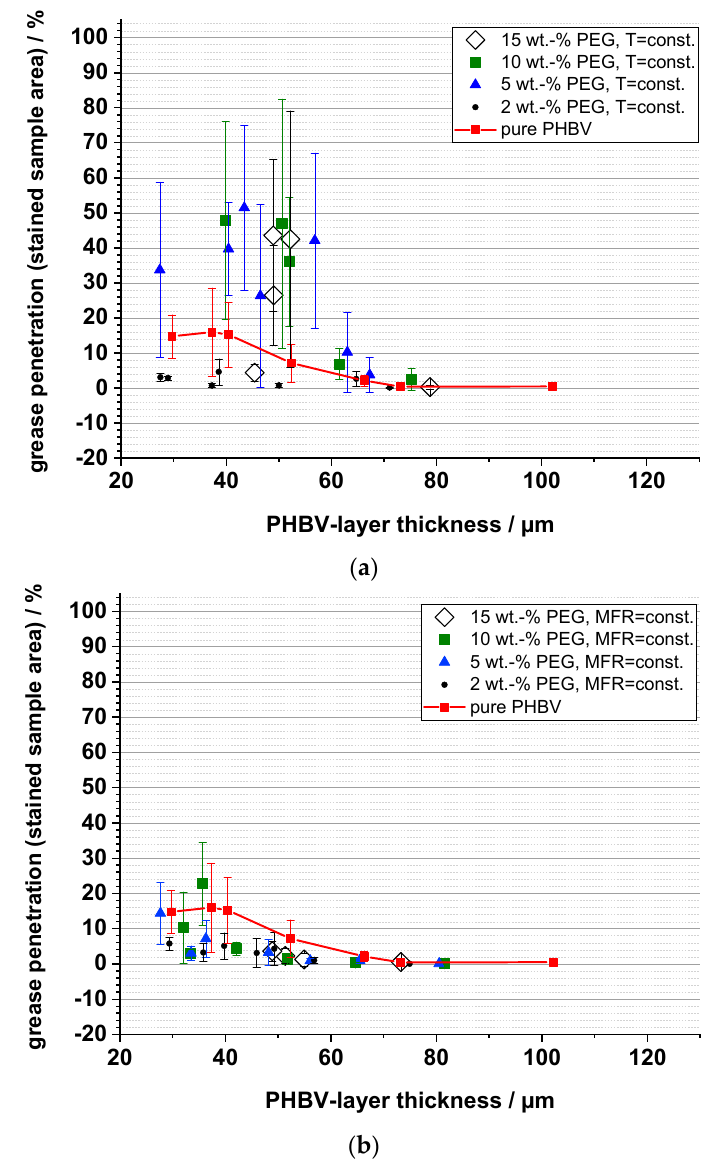
Figure 15. Grease barrier (staining) of paper coated with PHBV layers blended with polyethylene glycol (PEG): ( a ) temperature (T) during extrusion constant; ( b ) melt flow rate (MFR) during extrusion constant. Thickness: PHBV thickness.